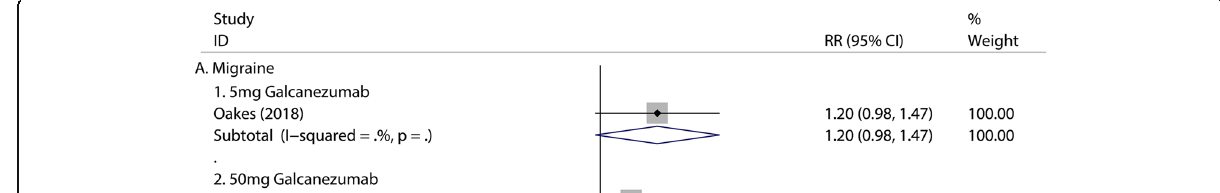
Fig. 2 Summary table for potential bias analysis for included study